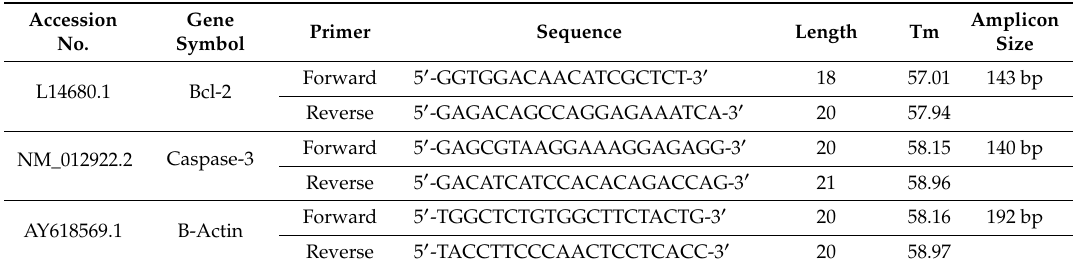
Table 2. The nucleotide sequence of PCR primers for amplification and sequence-specific detection of cDNA (obtained from the GenBank